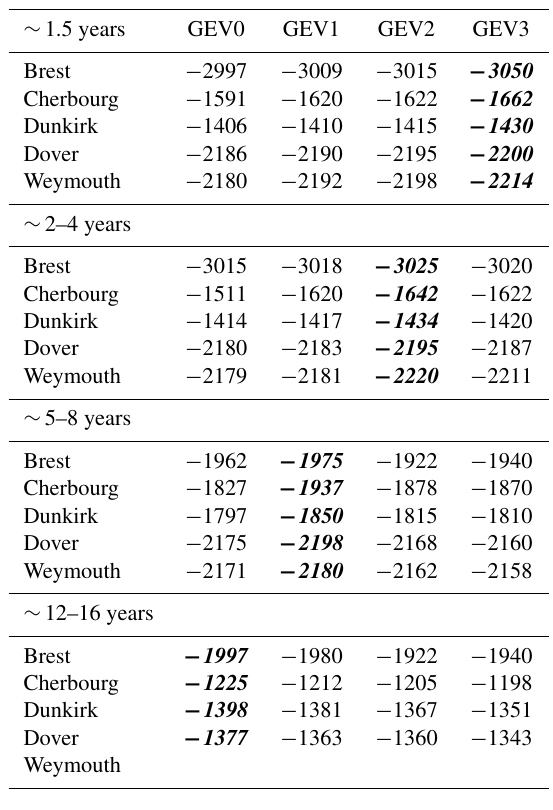
problems of uncertainty of the most appropriate climate to use as a covariate for GEV models at each timescale. How- ever, additional models (e.g. significance tests and sensitivity analyses and modelling uncertainties) and application sites (e.g. Mediterranean and Pacific ones controlled by other cli- mate oscillations) are required to expand the developed ap-